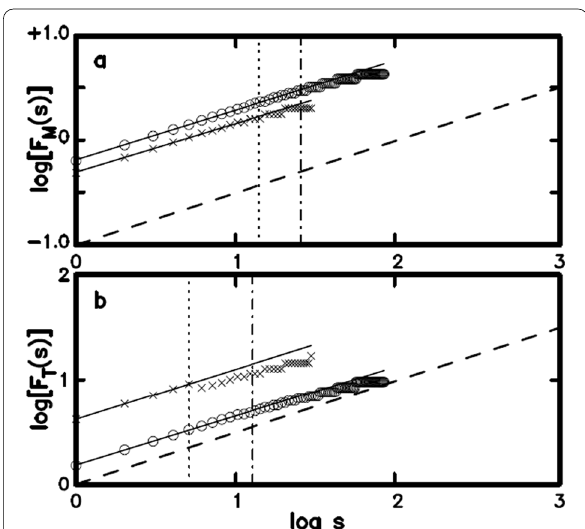
Fig. 8 a The log–log plot of fluctuation, F M (s) , versus time window, s , for M L 3 earthquakes (open circles) and M L 4 events (crosses). ≥ ≥ The upper bound of the range for linear regression is denoted by a dashed‑dotted vertical line, i.e., log( s ) 1.4, for M L 3 and by a dotted = ≥ vertical line, i.e., log( s ) 1.14, for M L 4. The dashed lines denote the = ≥ linear equation with a slope value of 0.5. The thin solid lines represent the inferred linear regression equations of log[ F M (s) ] a M α M log( s ) = + from the data sets with log( s ) in a range as listed in Table 1. b The log–log plot of fluctuation, F T (s) , versus time window, s , for M L 3 earthquakes (open circles) and M L 4 events (crosses). The ≥ ≥ upper bound of the range for linear regression is denoted by a dashed‑dotted vertical line, i.e., log( s ) 1.1, for M L 3 and by a dotted = ≥ vertical line, i.e., log( s ) 0.7, for M L 4.The dashed lines denote the = ≥ linear equation with a slope value of 0.5. The thin solid lines represent the inferred linear regression equations of log[ F T (s) ] a T α T log( s ) = + from the data sets with log( s ) in a range as listed in Table